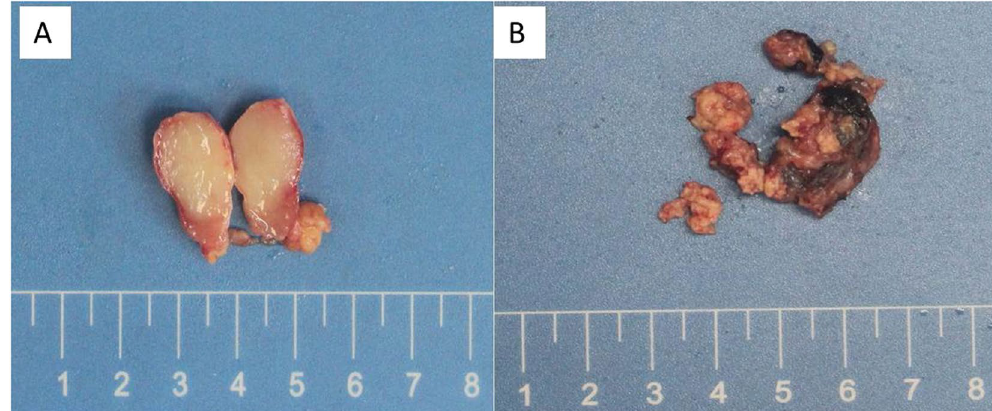
Figure 1. The section of case 1 was solid, white-grayish, fine and smooth, no bleeding and necrosis ( A ). Case 2 presented smashed white-grayish lymph nodes and the section was solid, white-grayish, focal black, rough and patchy necrosis ( B